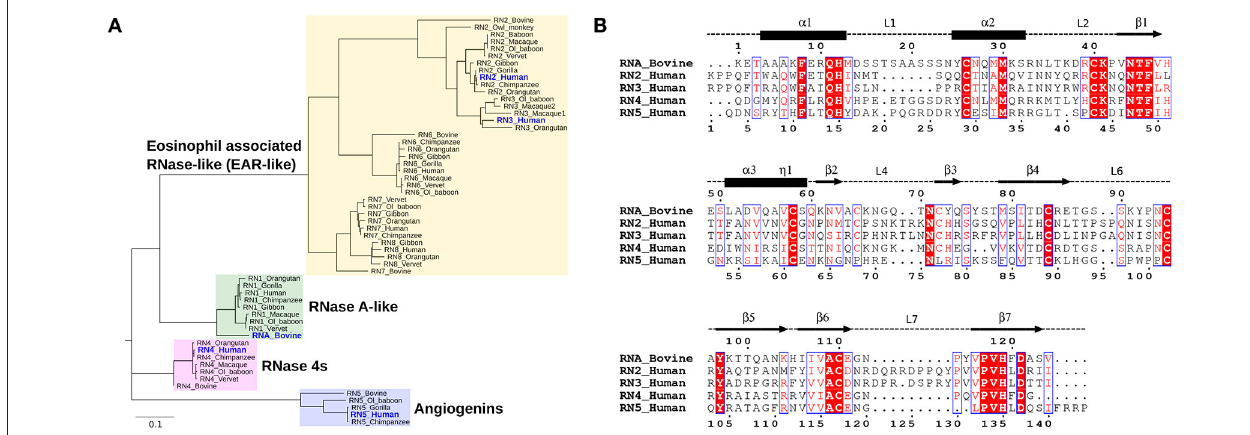
FIGURE 2 | Sequence characterization of pancreatic-type RNases. (A) Phylogenetic clustering of Hominidae and bovine RNases 1–8 groups RNases into four subfamilies . The multiple sequence alignment of all RNases used for this analysis is shown in Figure S2. (B) Multiple sequence alignment of bovine RNase A (RNA_Bovine), human RNases 2 (RN2_Human), 3 (RN3_Human), 4 (RN4_Human), and 5 (RN5_Human). The primary sequence numbering for RNase A and the consensus sequence, corresponding to sequence numbering including gaps in the alignment, are shown in the top and bottom of the alignment, respectively. Secondary structure of bovine RNase A is traced on top of the sequence alignment using blocks, arrows and dashed lines to represent α -helix, β -strand and loop regions, respectively. Sequence alignments were prepared using EsPript ( Robert and Gouet,